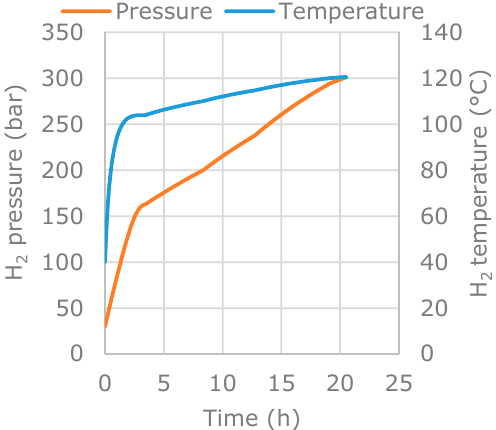
Figure 21. Energy density of CH 4 vs. H 2 .